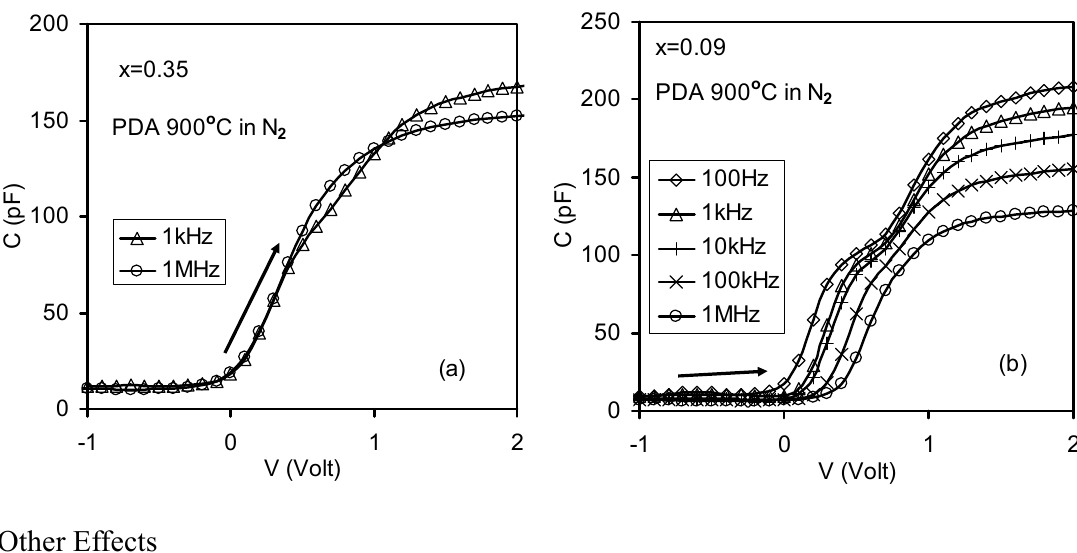
Zr O samples x 1 − x 2 −δ